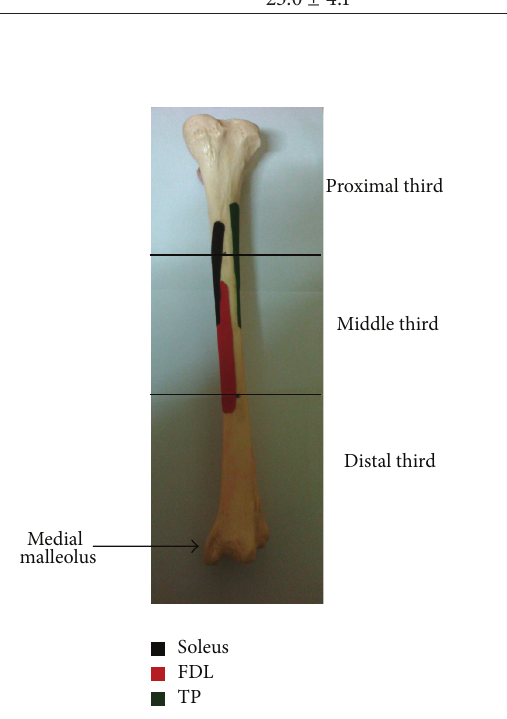
Figure 1: Site of muscle attachment on posterior aspect of the left tibia